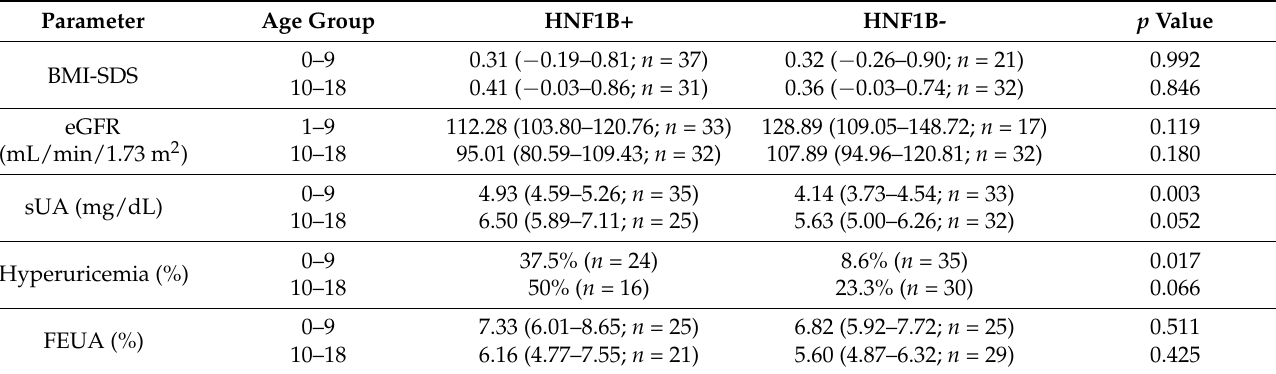
Table 3. Differences in serum uric acid levels, frequency of hyperuricemia and fractional excretion of uric acid between HNF1B positive and negative patients presented for age-specific